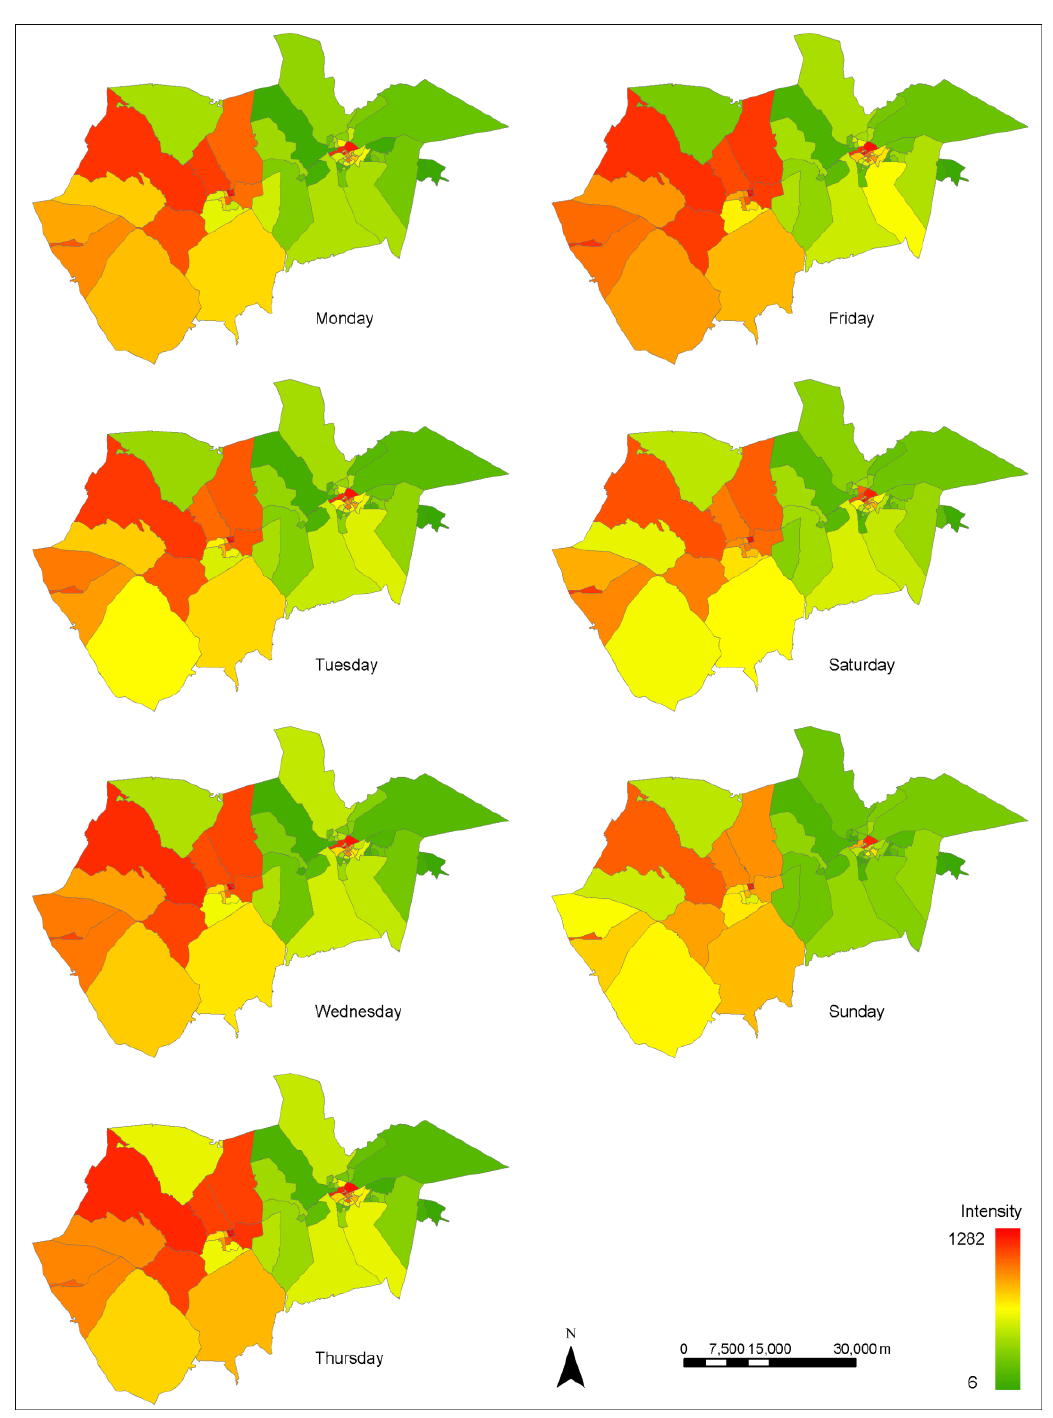
Figure 7. Map of the intensity of activities changing with time on a daily